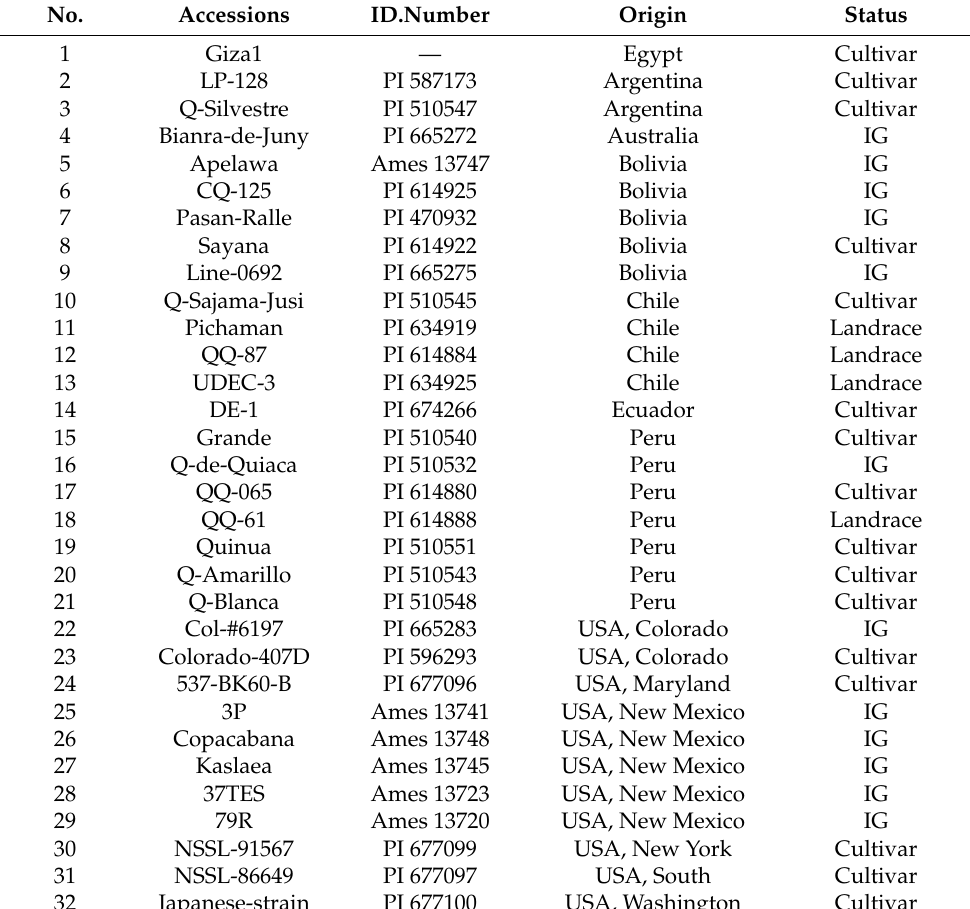
color at flowering (PCF), panicle color at maturity (PCM), panicle shape (PS), panicle density (PD), dehiscence degree (DD), perigonium appearance (PG), and perigonium color (PC). Quantitative measurements included plant height (PH), stem diameter (SD), number of branches/plant (NoB), panicle length (PL), panicle width (PW), petiole length (PeL), leaf length (LL), leaf width (LW), leaf area (LA), the number of teeth/leaf (NoT), and the number of days from sowing to 95% maturity (MD). Table 1. The genotype name, ID number, origin, and status of each of the 32 quinoa genotypes used in the